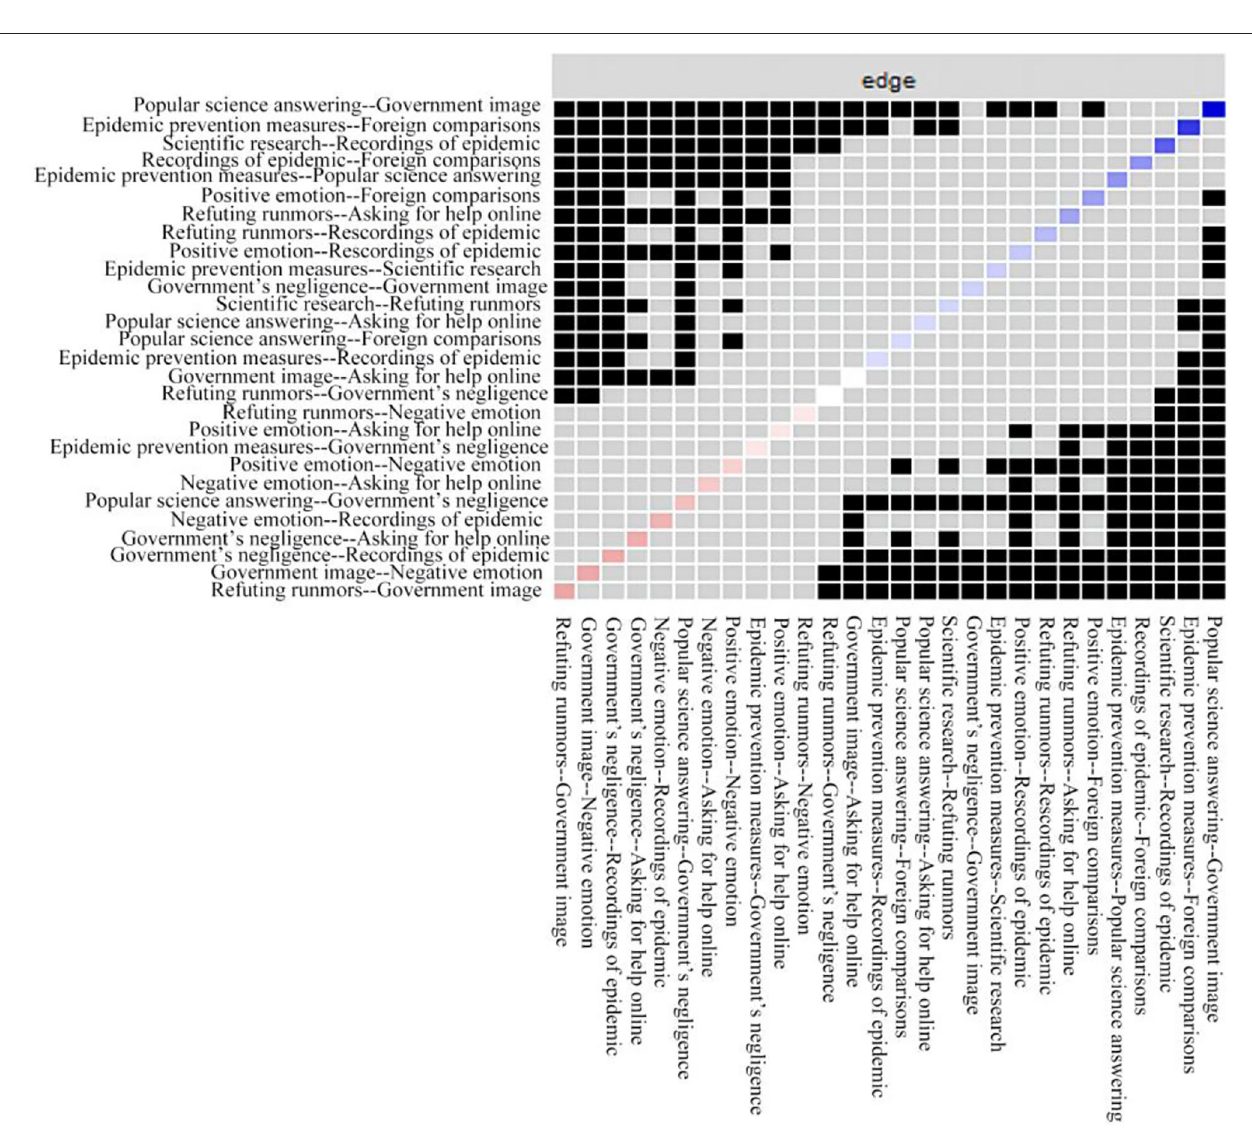
FIGURE 2 | The edge weight difference test of the Weibo topic